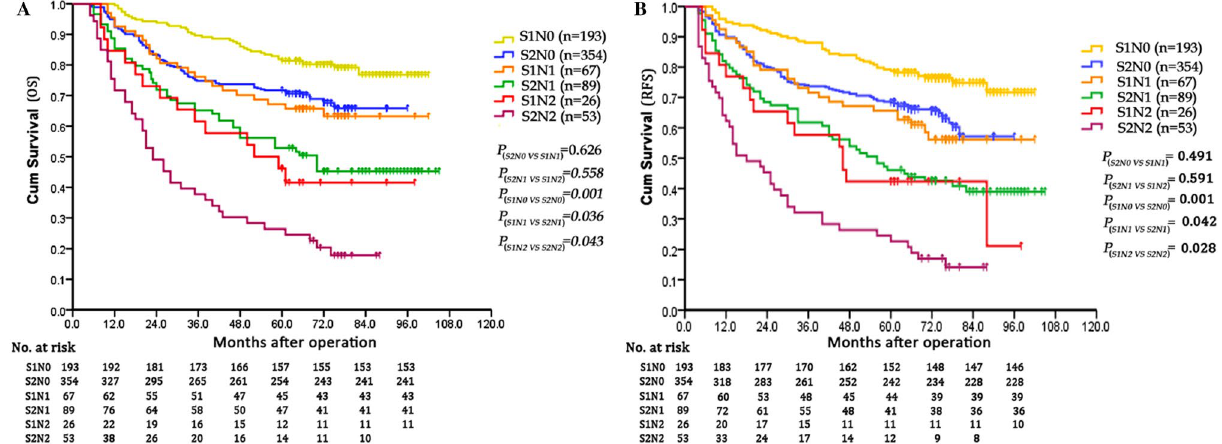
Figure 5. Comparison of survival curves of T4aM0 stage patients with different N stages and tumor sizes. ( A ) The OS of N0-stage patients with S2-size was similar to that of N1-stage patients with S1-size ( P = 0.626). The OS of N1-stage patients with S2-size was equal to that of N2-stage patients with S2-size ( P = 0.558). ( B ) The RFS of N0-stage patients with S2-size was similar to that of N1-stage patients with S1-size ( P = 0.491). The RFS of N1-stage patients with S2-size was equal to that of N2-stage patients with S2-size ( P = 0.591).